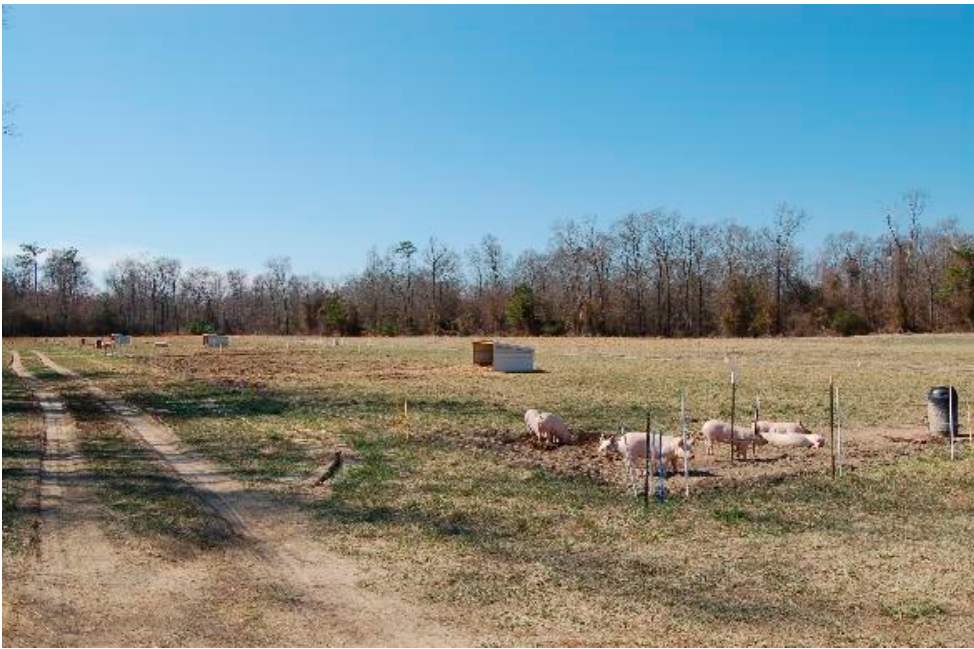
Figure 3. View of a paddock managed under the continuous stocking method during the first grazing period (December to March).